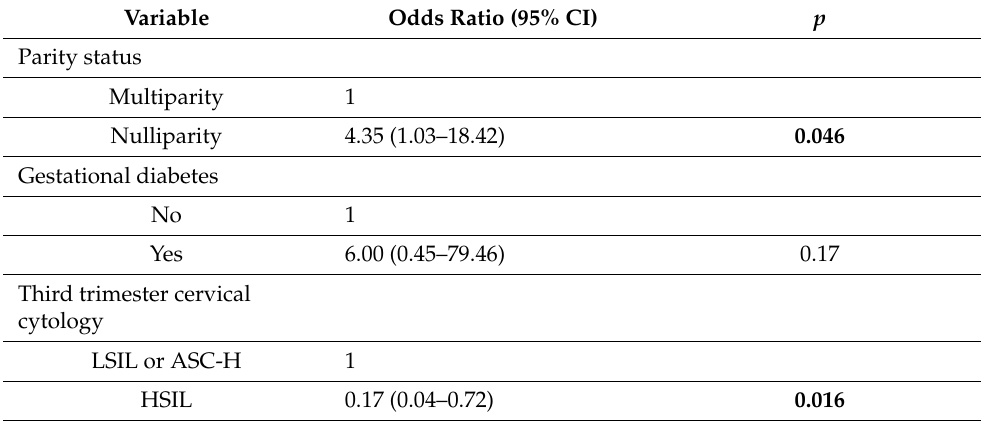
Table 5. Multivariate analysis of factors associated with postpartum CIN